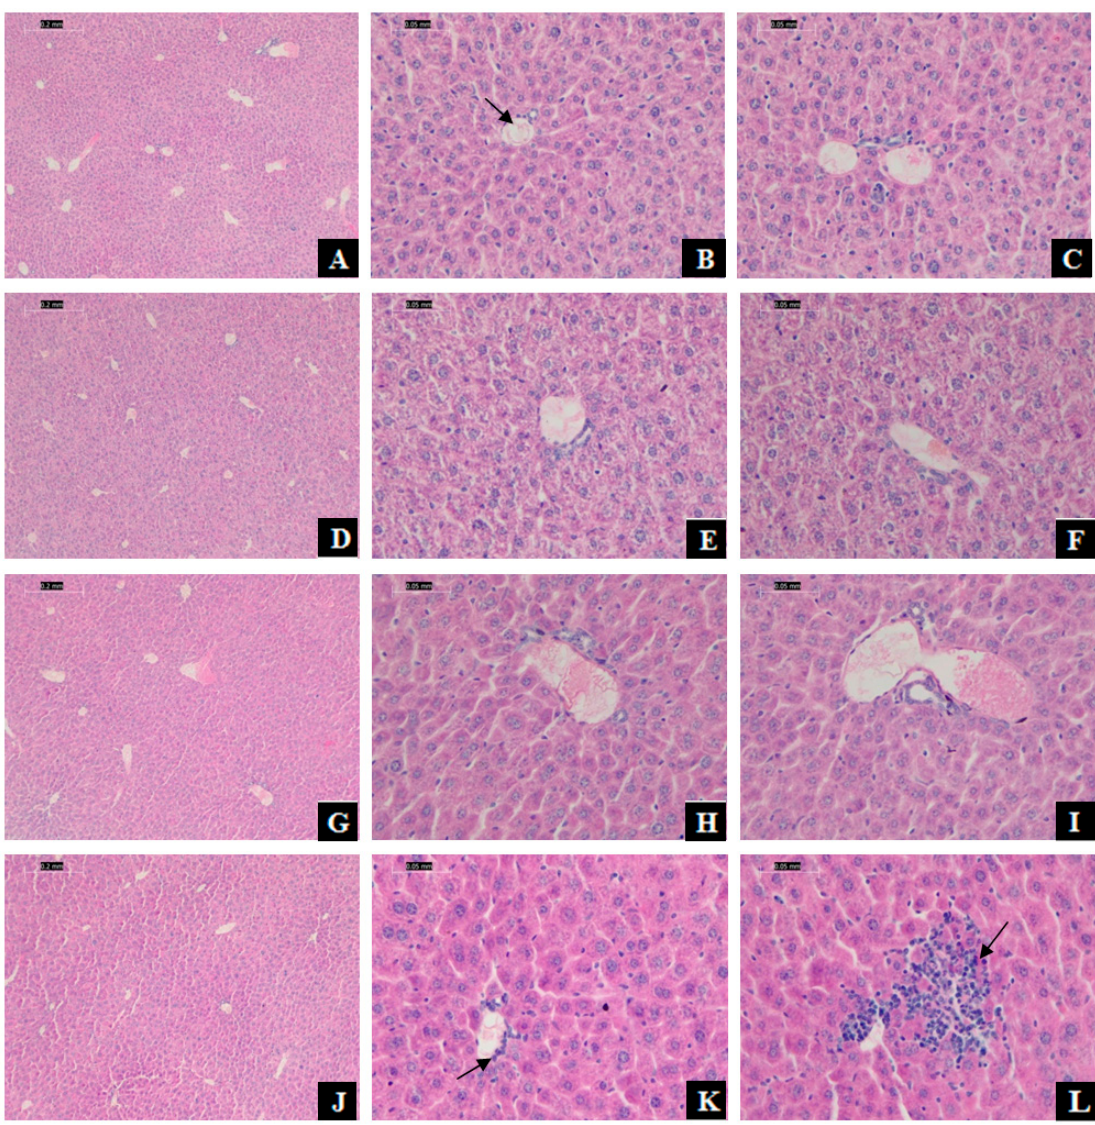
Figure 2. Effect of DEHP exposure on histopathology of mice liver. Photomicrographs of sections stained with hematoxylin-eosin (H&E) from mice liver tissue. Scale bar was 0.2 and 0.5 mm. ( A – C ): Hepatic cross-sections from the control group (treated with corn oil), with the normal hepatic lobules and cell structure, the cells radially arranged around the central vein (B: arrowhead) to form the hepatic cord; ( D – F ): Hepatic cross-sections from 125 mg/kg DEHP group; ( G – I ): Hepatic cross-sections from 250 mg/kg DEHP group; ( J – L ): Hepatic cross-sections from 375 mg/kg DEHP group with a small agglomeration of leukocytes in the venule (K: arrowhead) and inflammatory cells infiltration (L: arrowhead).